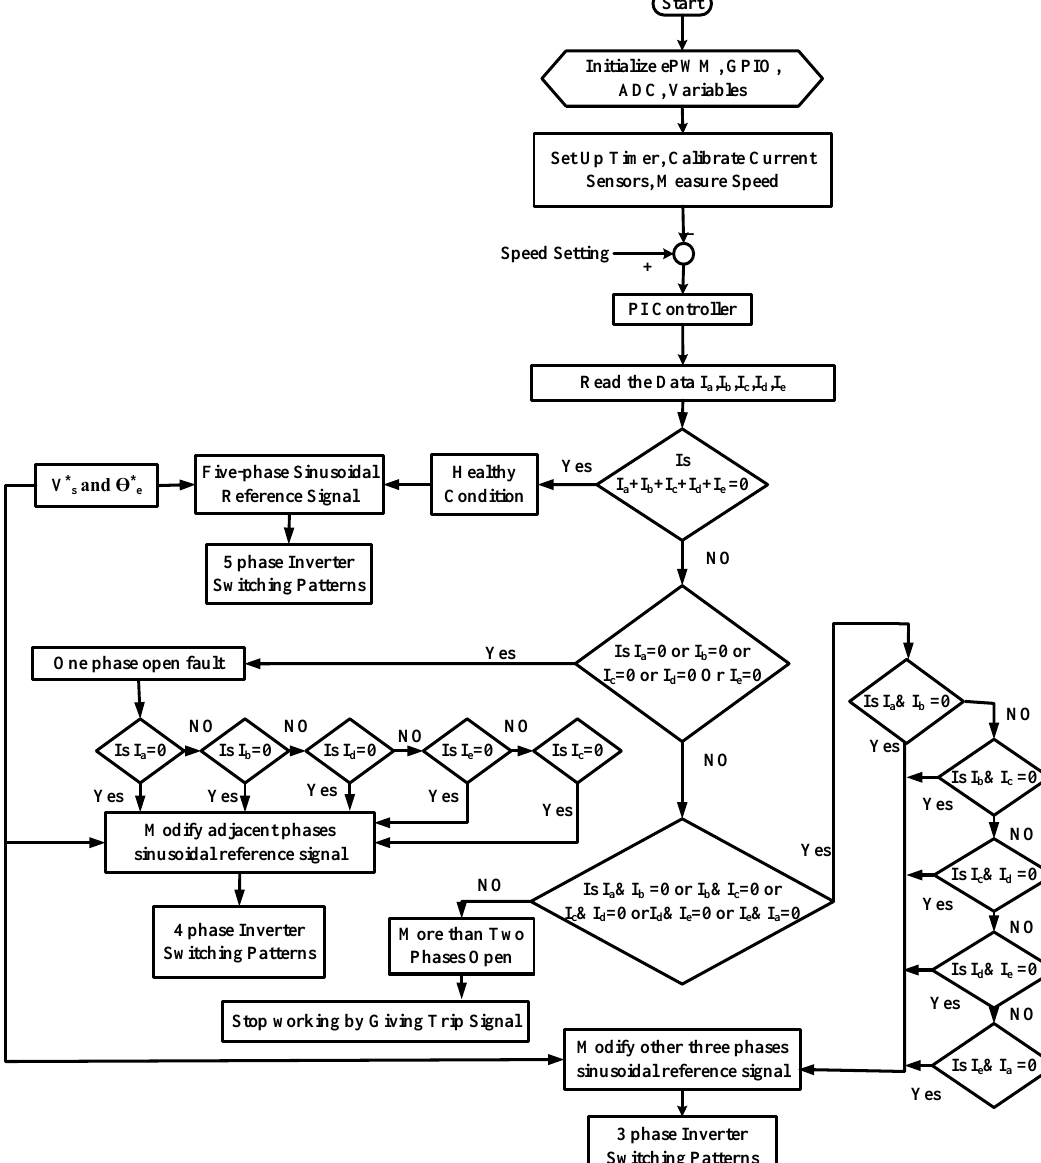
Figure 4. Flow-chart of fault-tolerant control strategy.